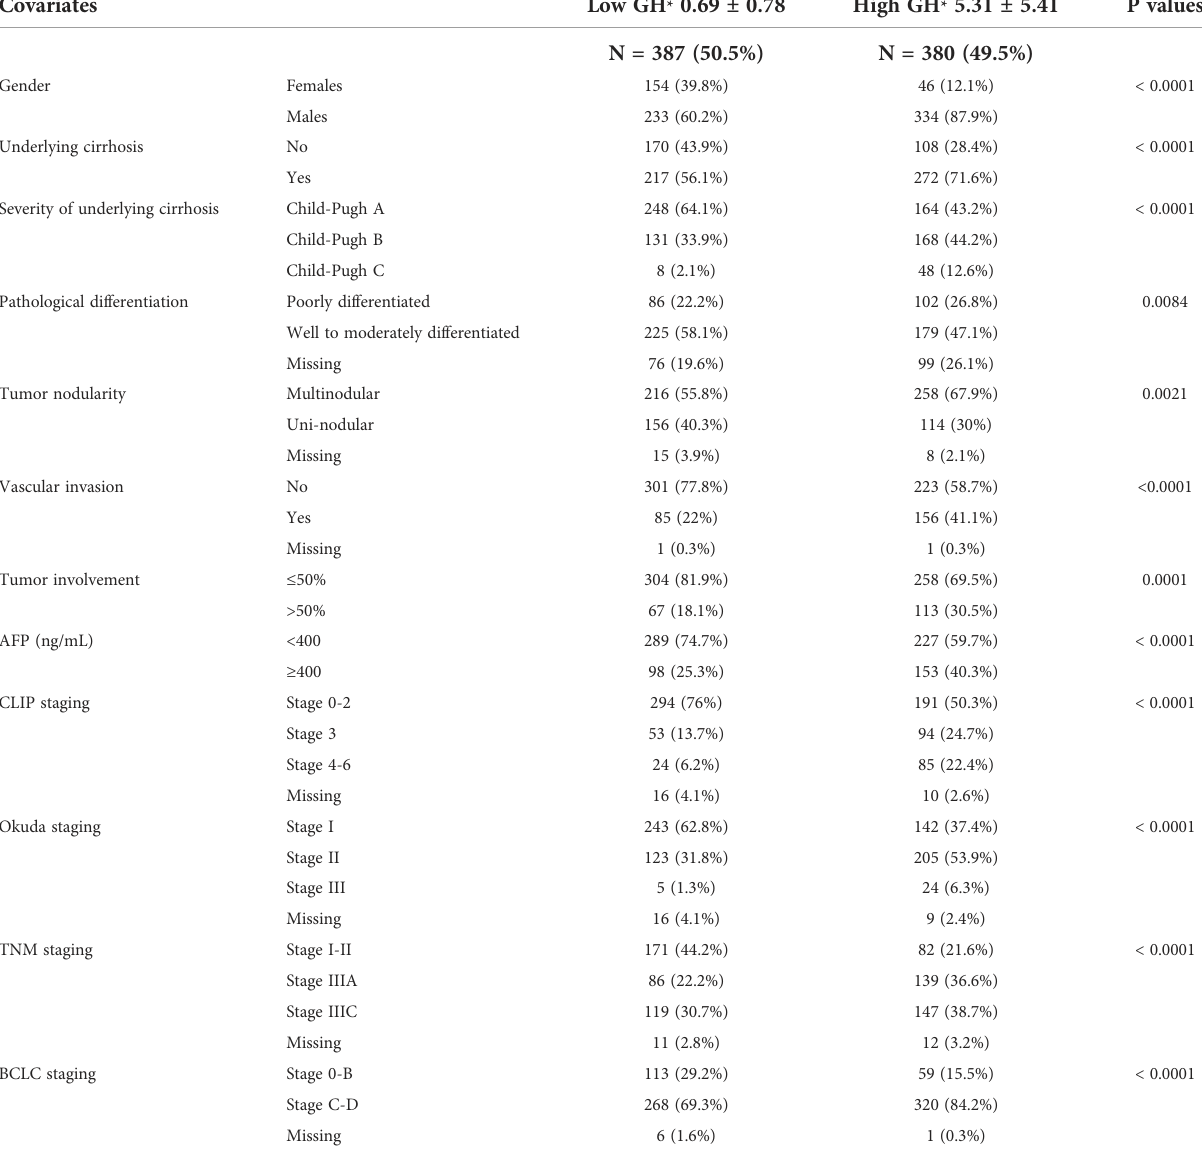
TABLE 1 Clinicopathological characteristics on HCC patients with low vs. high GH levels.